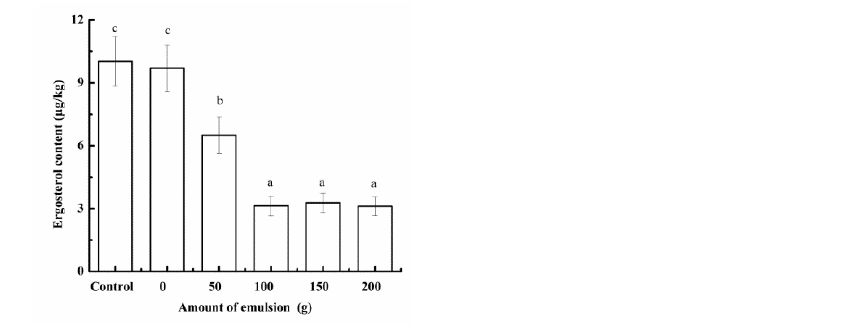
Figure 10. Effect of adding secondary emulsion during third soaking on ergosterol content in malt.